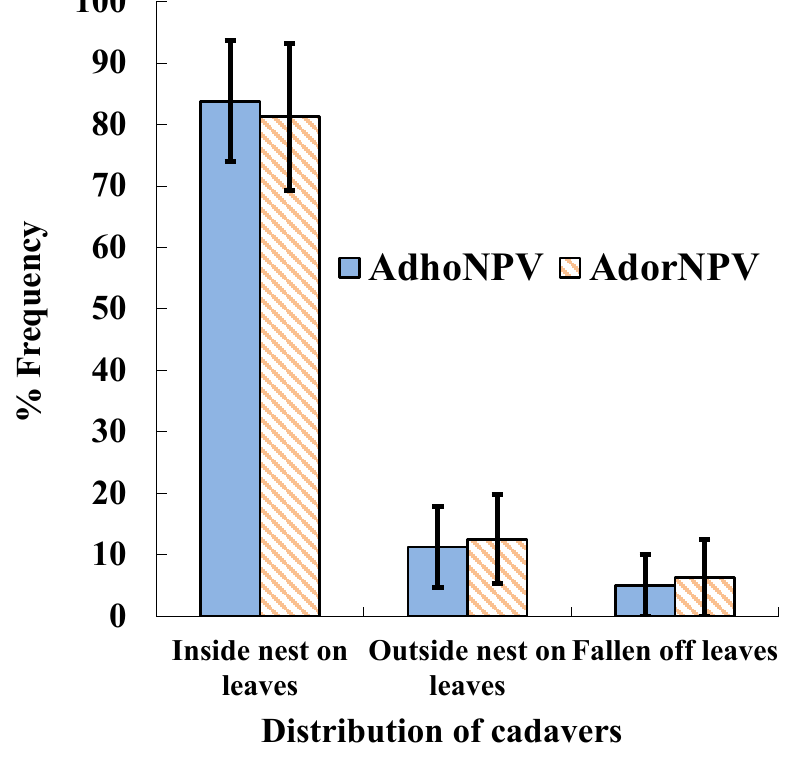
Figure 6. Location of A. honmai cadavers killed by AdhoNPV and AdorNPV on tea leaves. Bars indicate standard